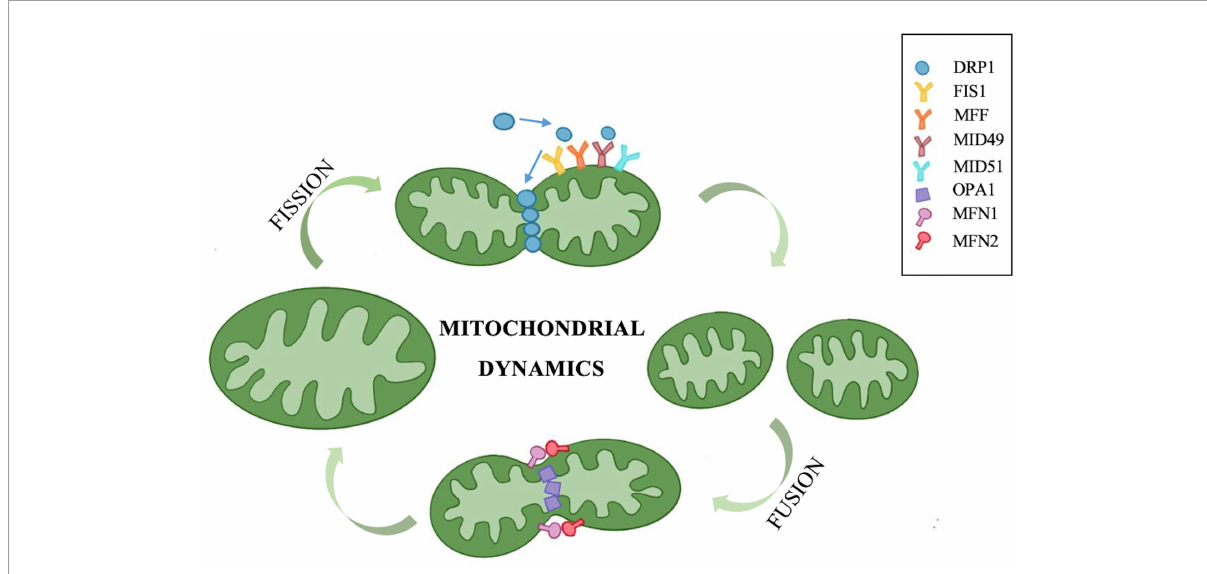
FIGURE1 Mitochondrial fission and fusion maintain a dynamic equilibrium via a series of molecules. The GTPase DRP1 located in the cytoplasm plays a dominant role in mitochondrial fission. The DRP1 receptor proteins FIS1, MFF, and MID49/51 are all distributed in the outer mitochondrial membrane. These receptor proteins can recruit DRP1 to the outer membrane to form a helical structure that hydrolyzes GTP, induces mitochondrial constriction and severing, and promotes mitochondrial fission. OPA1, MFN1, and MFN2 are three types of GTPases that govern mitochondrial fusion. MFN1 and MFN2 are localized in the outer mitochondrial membrane and form homologous or heterologous complexes that mediate mitochondrial coupling. OPA1 is involved in inner mitochondrial membrane fusion and the connection of cristae remodeling, and OPA1 mediates inner membrane fusion in turn after outer membrane